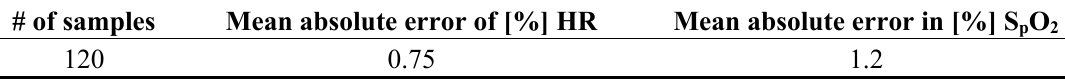
Table 2. Accuracy against industrial reference.